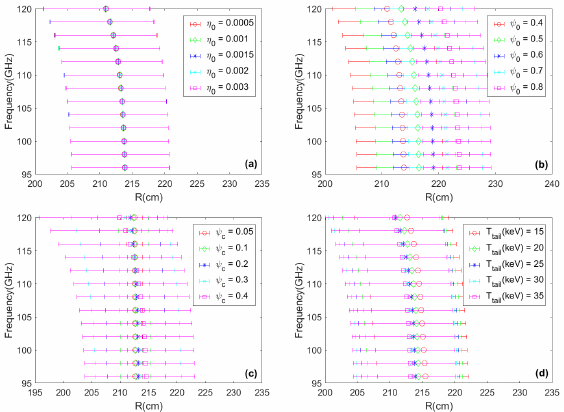
Figure 10. The localization (position defined at the peak value, width defined as the FWHM) of the non-thermal emission layer for scan of (a) the fractional density ( ψ 0 = 0 . 4, ∆ ψ = 0 . 3, T tail = 25 keV, u (cid:107) , max = 0 . 4), (b) the radial position ( η 0 = 0 . 001, ∆ ψ = 0 . 3, T tail = 25 keV, u (cid:107) , max = 0 . 4), (c) the radial distribution ( η 0 = 0 . 001, ψ 0 = 0 . 4, T tail = 25 keV, u (cid:107) , max = 0 . 4), and (d) the tail energy ( η 0 = 0 . 001, ψ 0 = 0 . 4, ∆ ψ = 0 . 3, u (cid:107) , max = 0 .